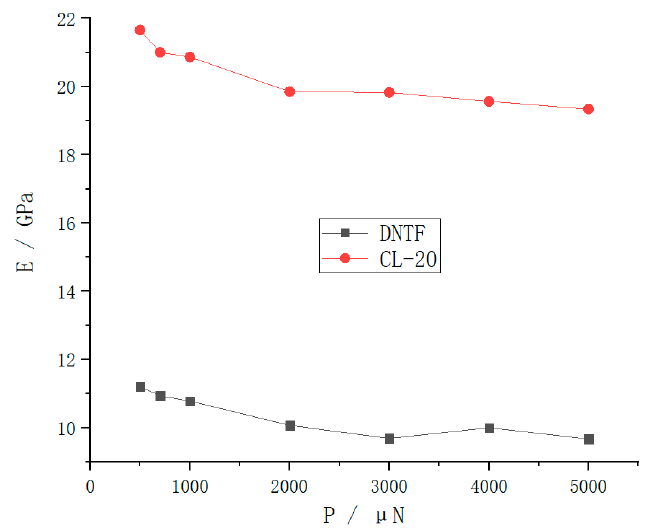
Figure 6. Load–crystal modulus of elasticity curve.